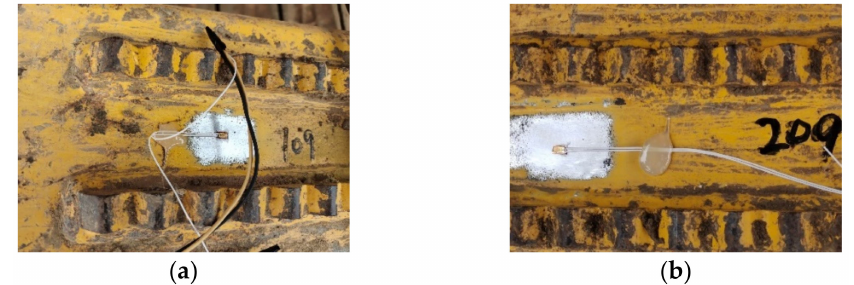
Figure 12. Strain gauges in experiment: ( a ) left push arm; ( b ) right push